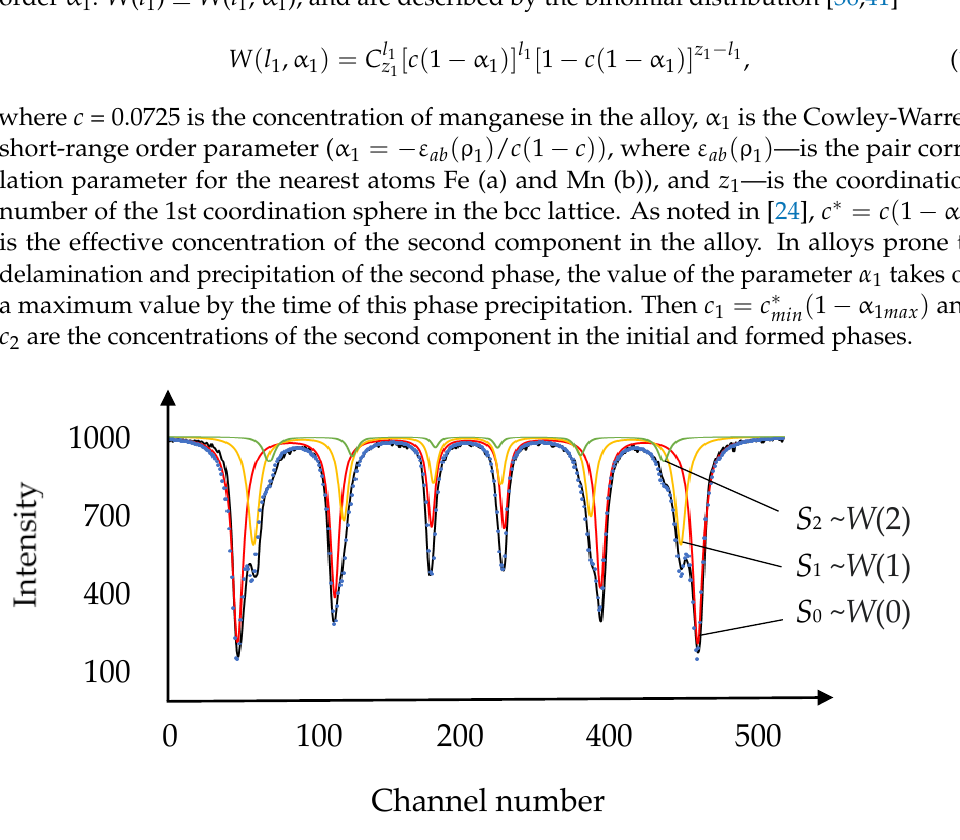
Figure 2. An example of the decomposition of the Mössbauer spectrum of the Fe-6.29 at.% Mn alloy in a single-phase state into constituent sextets [41].